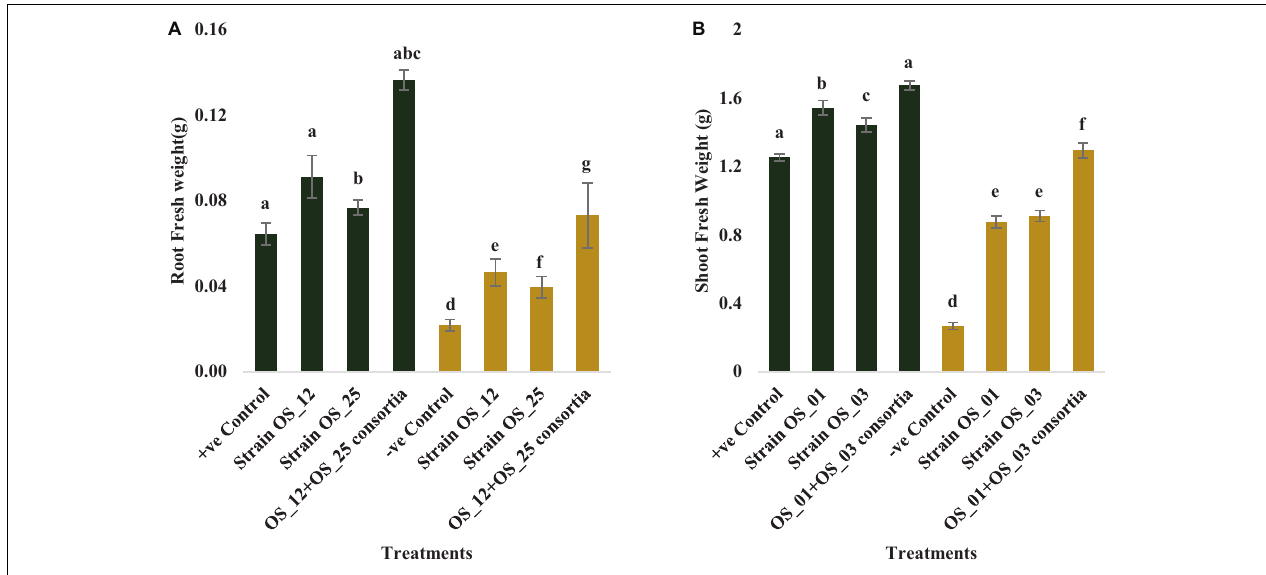
FIGURE 8 | Effect of seed biopriming with endophytic biostimulant strains OS_12 and OS_25 plant on fresh weight of root (A) and shoot (B) biomass of pea plants sown in plastic pots under normal (green bar) and pathogenic F. oxysporum stress (purple bar) conditions. Columns represent Mean values ± standard deviation ( n = 3 replicates per treatment). Different letters indicate statistical difference between treatments (Turkey’s posttest, P < 0.05) under normal and biotic stress conditions.